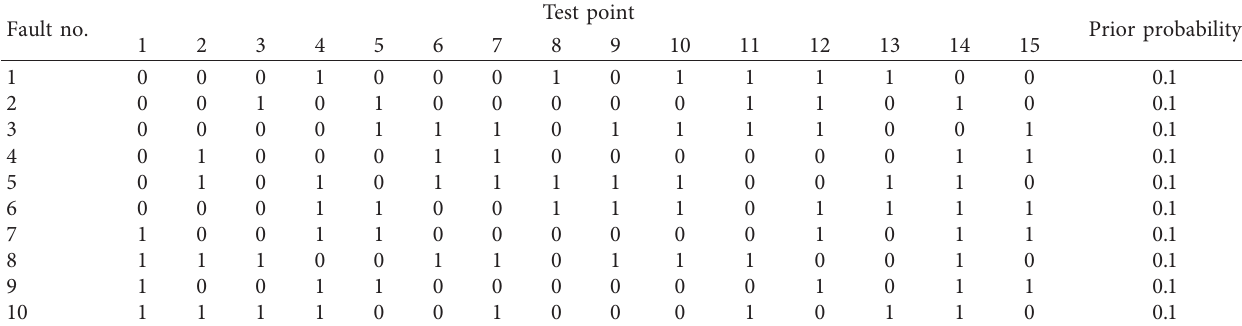
Table 1: The dependency matrix for fault status and test in the system of Apollo spacecraft. Fault no.